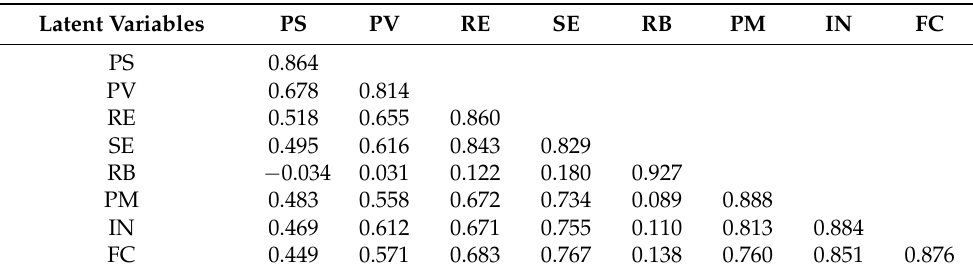
Table 4. The correlation coefficients of latent variables and discriminant validity. Note: The bold values in diagonal represent the sqrt (AVE)